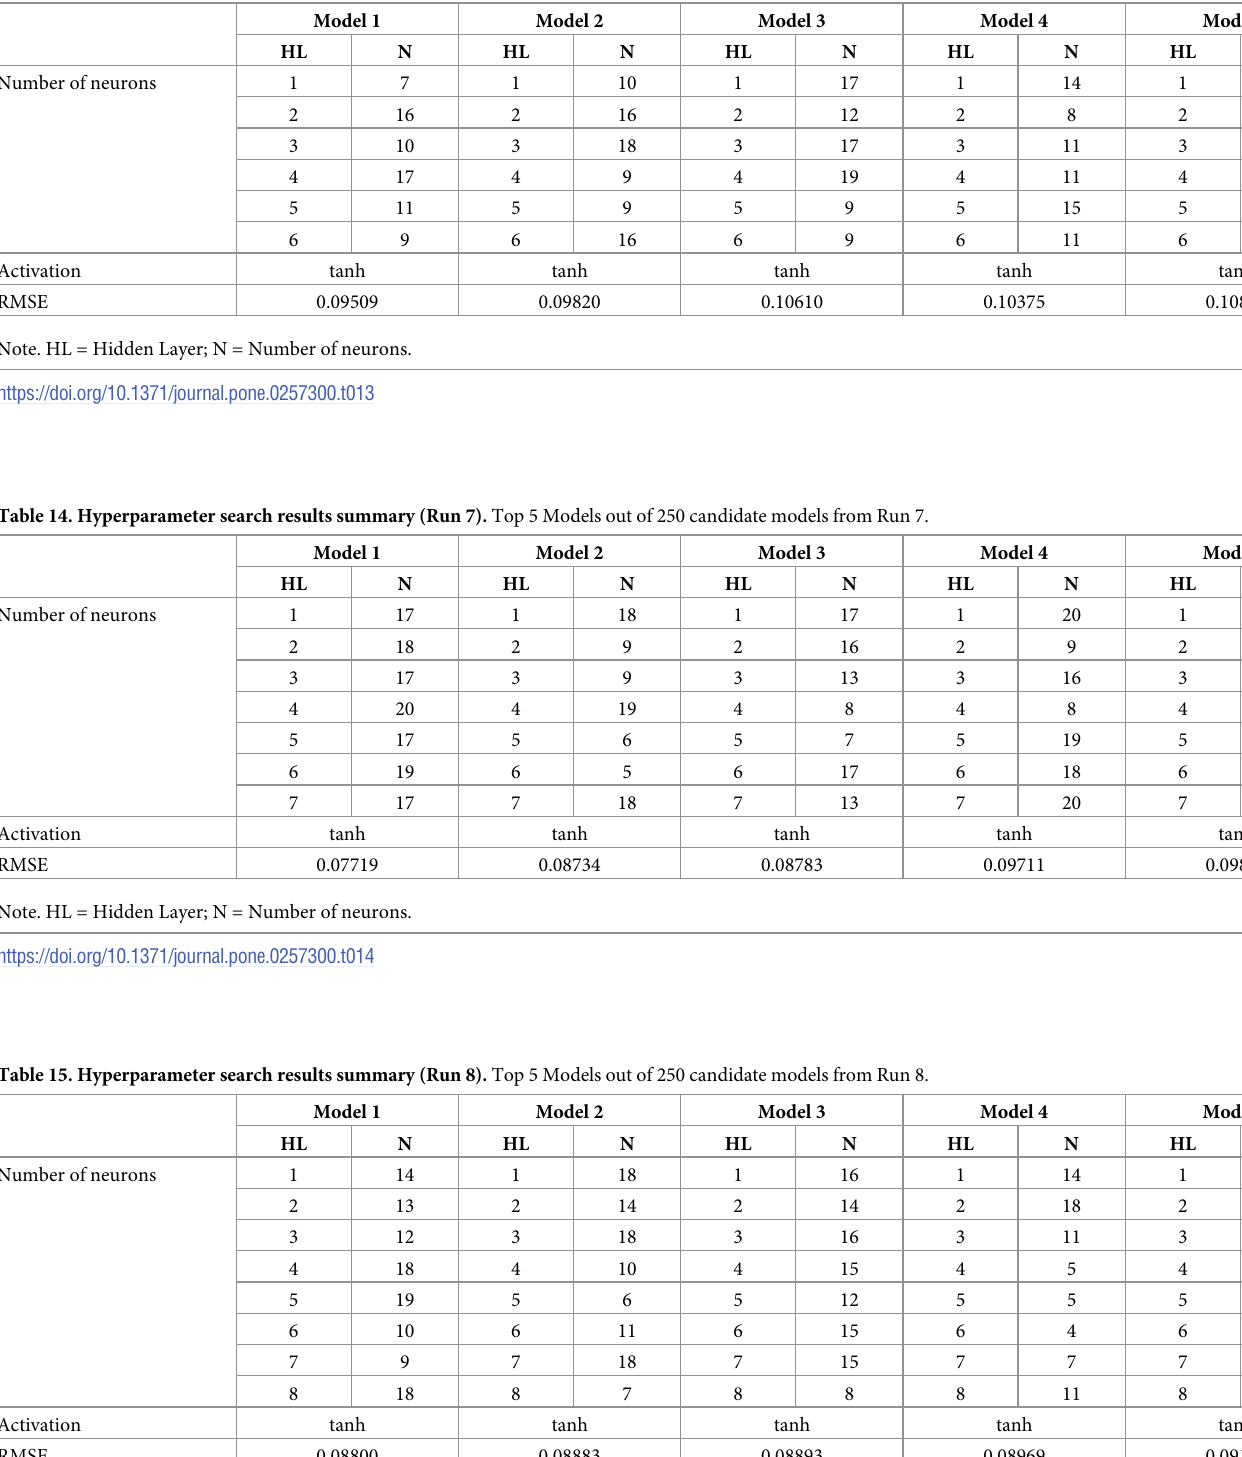
Number of neurons